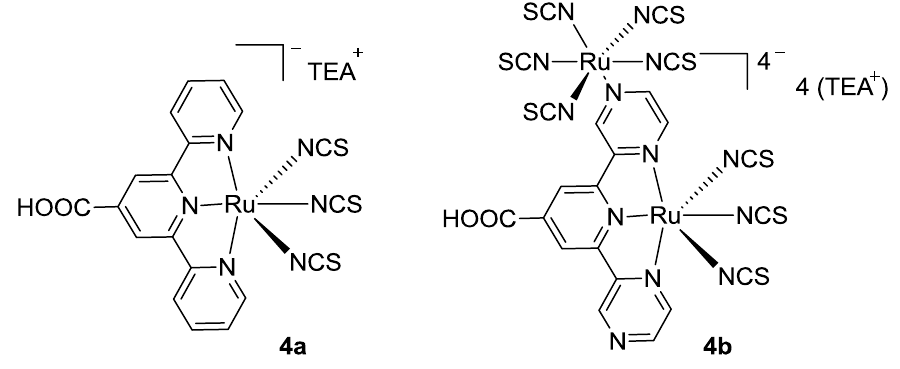
Figure 6. Complexes with one ( 4a ) or two ( 4b ) metal centers [74].